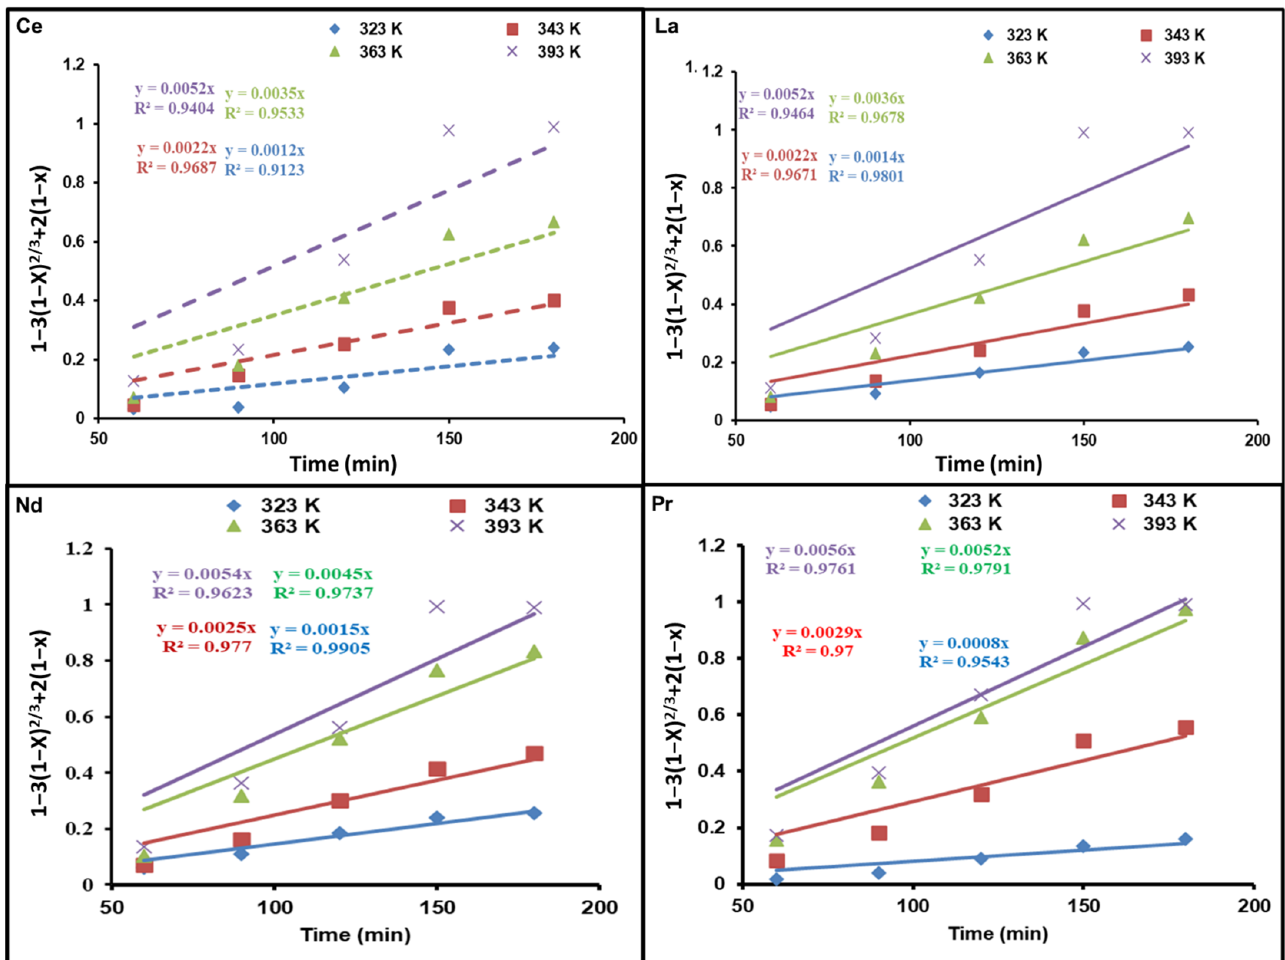
Figure 6. Influence of dissolution time on fraction of REEs dissolved, 1 − 3(1 − x ) 2/3 + 2(1 − x ), at different